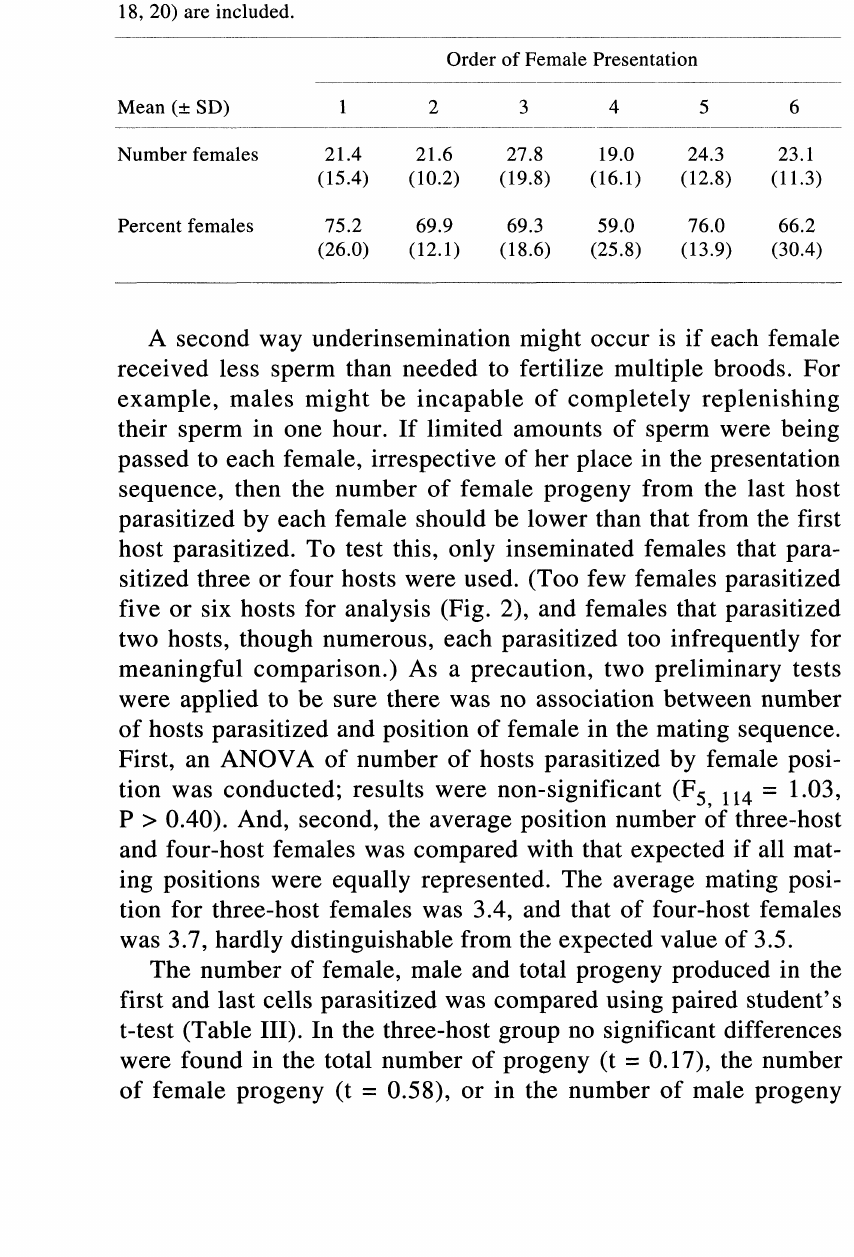
Table II. Mean number and percent (_+ SD) of female progeny produced by females according to their position in the mating-presentation sequence. Only data for males that inseminated all six of their mates (Numbers 4, 5, 6, 10, 11, 12, 13, 18, 20) are